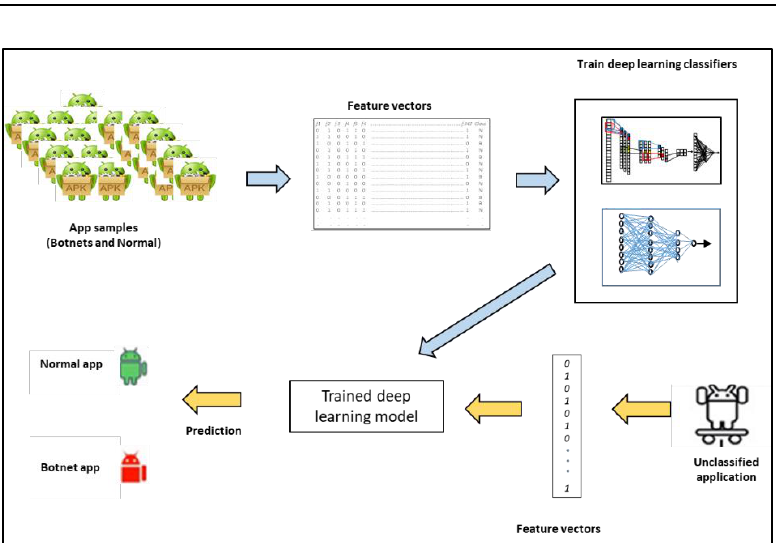
Figure 1. Overview of the deep learning-based detection system for Android botnets. Table 2. Examples of features extracted for the deep learning models.